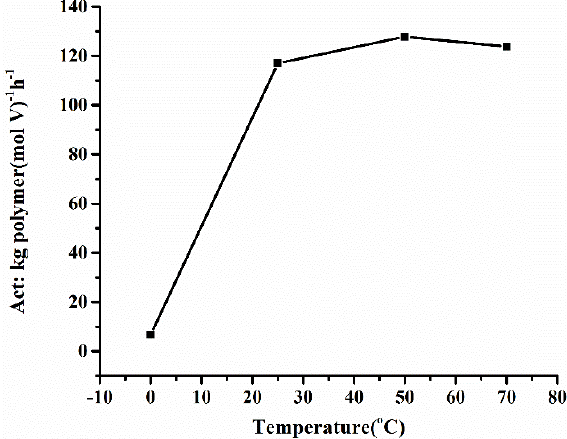
Figure 4. Catalytic activities of complex V3 with MAO at different temperature.